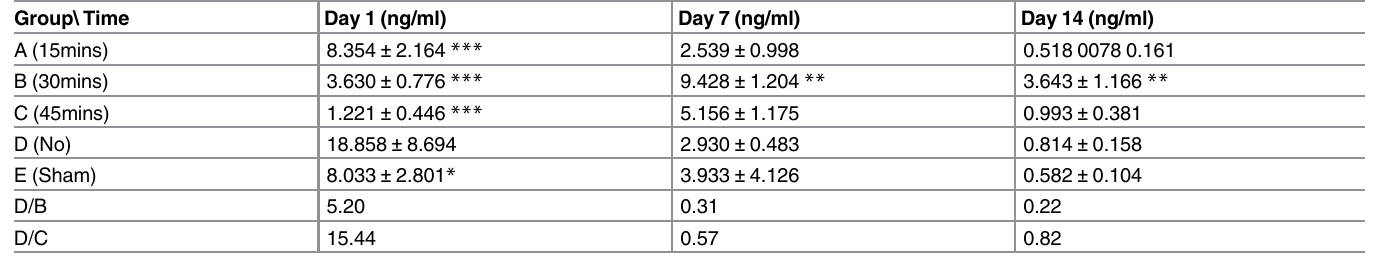
Table 2. PAI-I level in the peritoneum